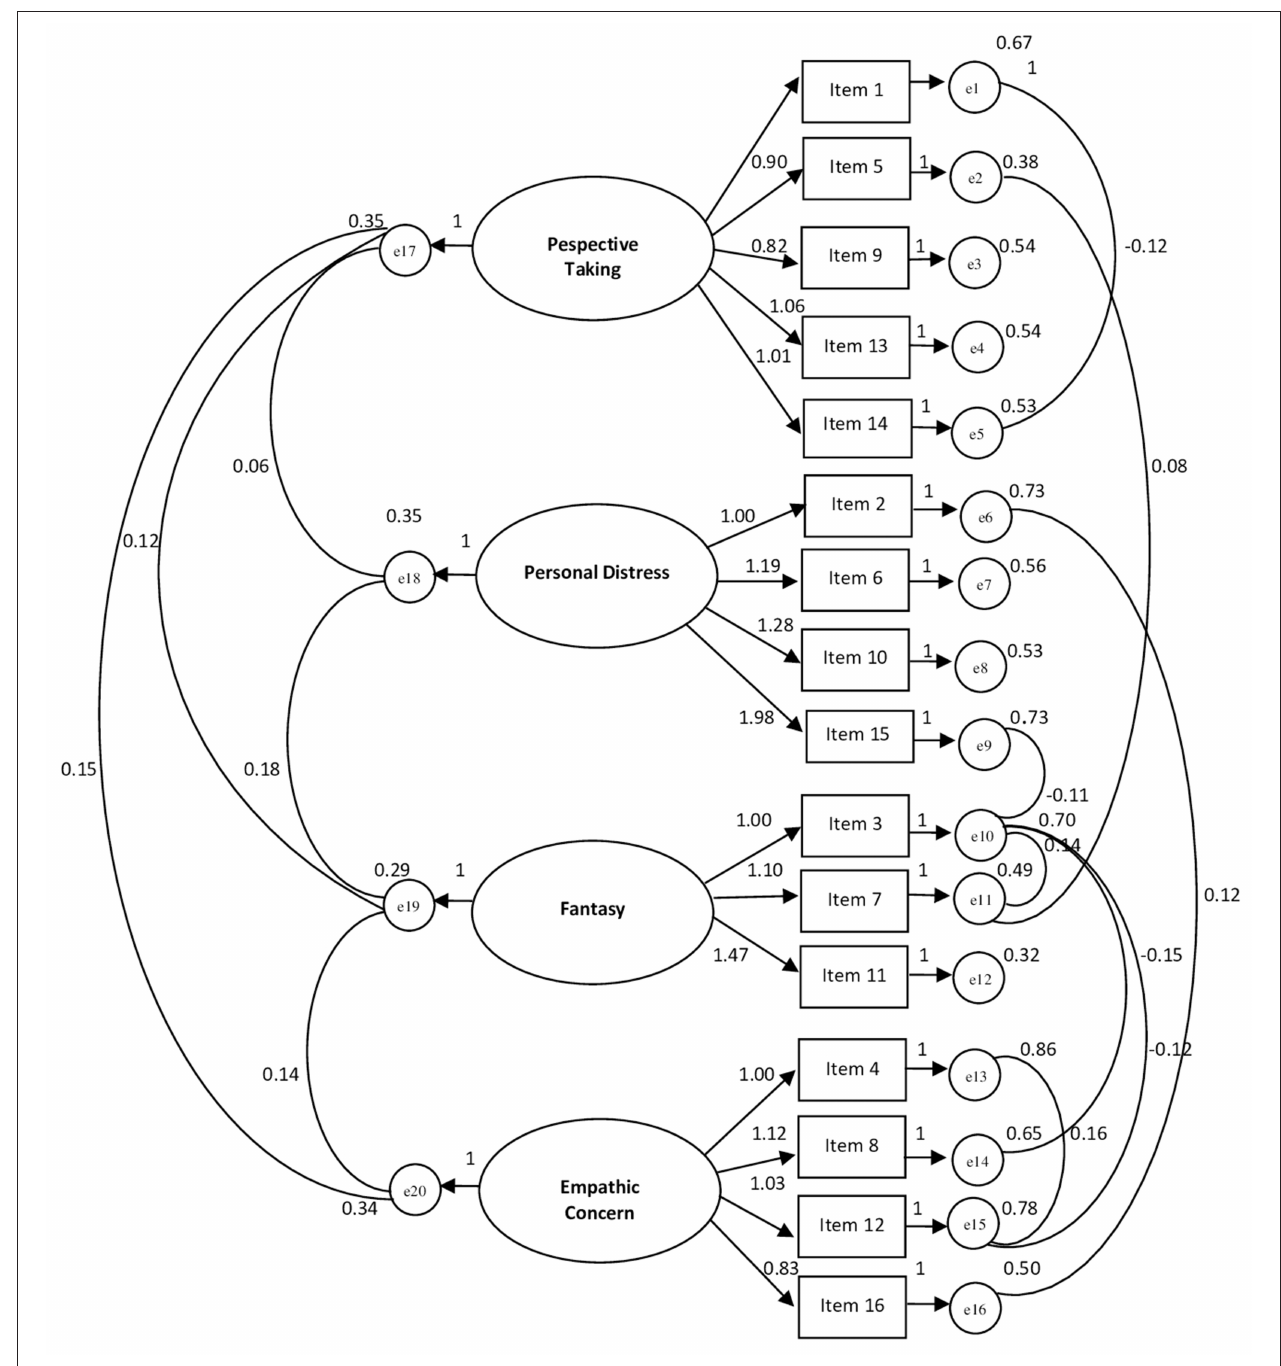
FIGURE 1 | Path diagram of the confirmatory analysis concerning IRI (16 items). χ 2 /df = 1.296; RMSEA = 0.031; RMSEA 90% CI = 0.010–0.047; GFI = 0.953; TLI = 0.968; CFI = 0.975; NFI =